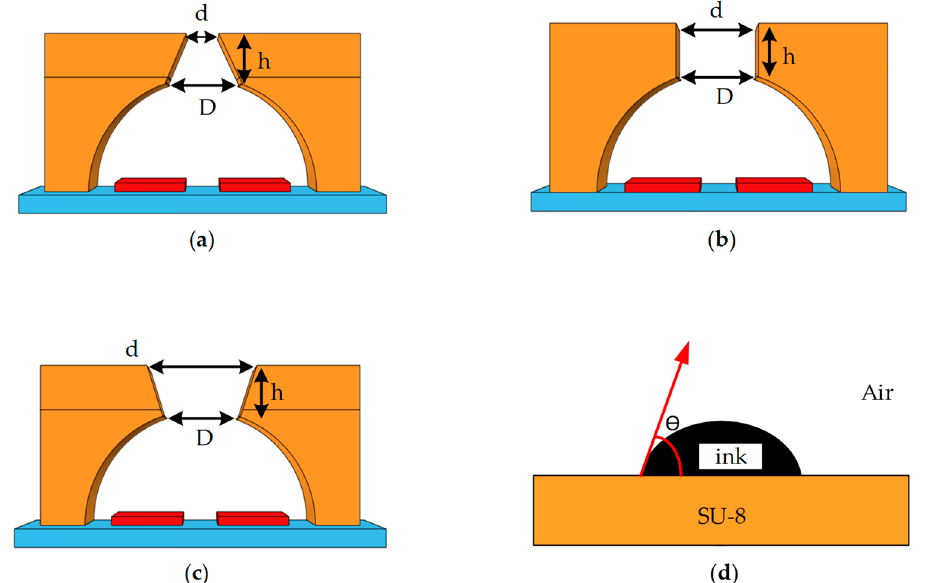
Figure 6. Inkjet heads with different nozzles and the contact angle of the SU-8 chamber. ( a ) Inkjet head equipped with conical shrinkage nozzle; ( b ) Inkjet head equipped with straight nozzle; ( c ) Inkjet head equipped with conical diffusion nozzle; ( d ) The contact angle of the SU-8 chamber.